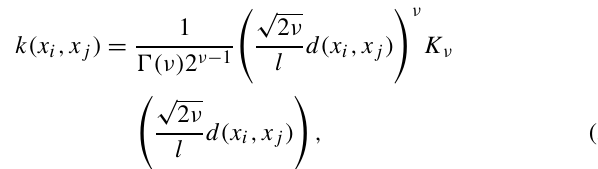
for a split at each node. The mean squared error of